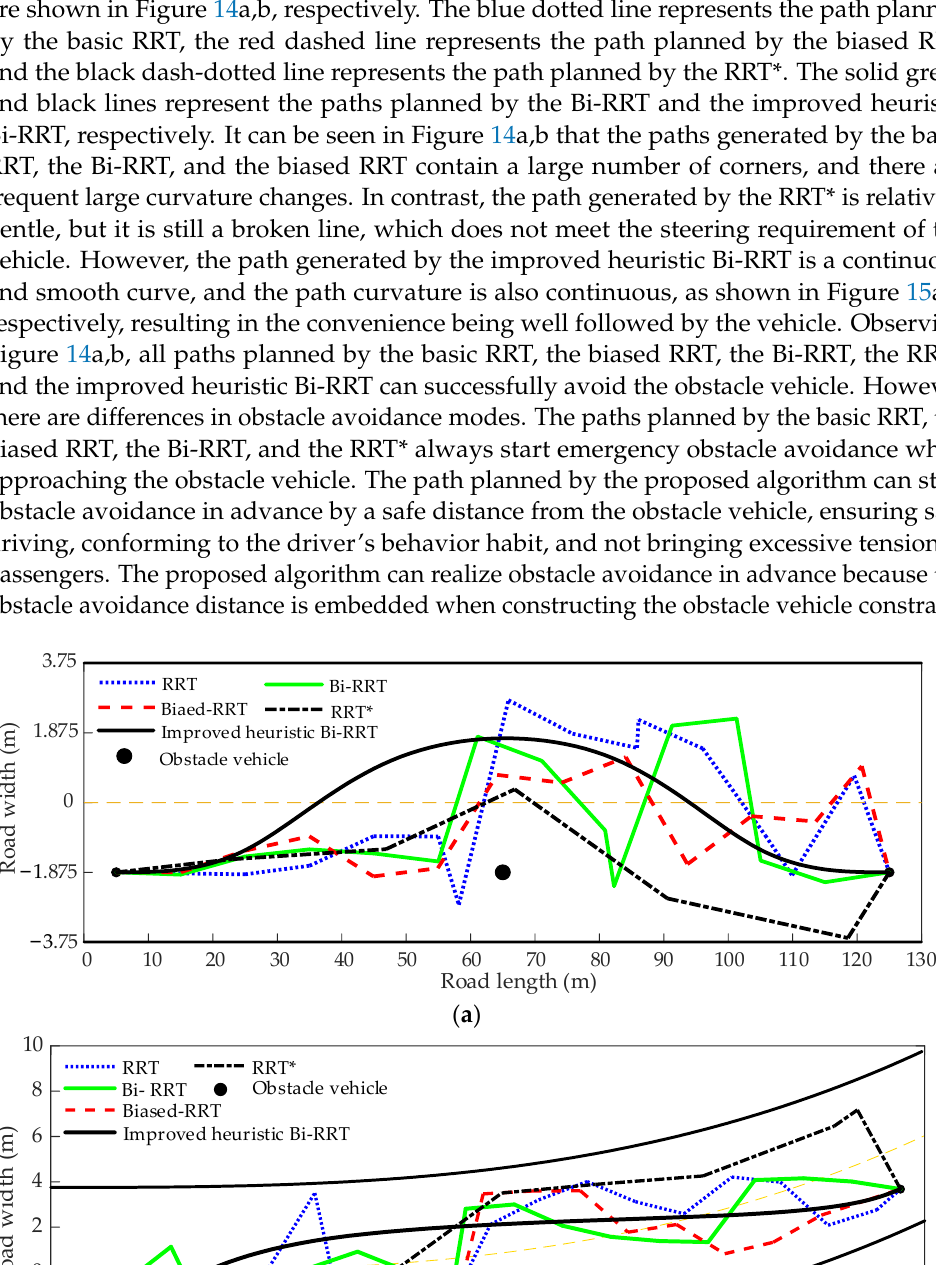
( b ) Figure 15. The simulation path curvatures. ( a ) The path curvature in straight road scenario. ( b ) The path curvature in curved road scenario.